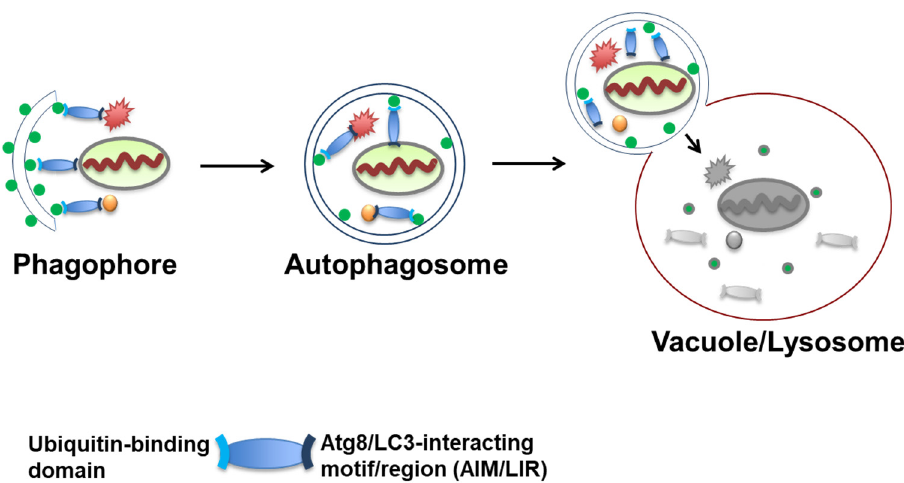
Figure 1. Autophagy pathway begins with the formation of a double-layered isolation membrane (phagophore), which sequesters autophagy cargo such as protein aggregates or organelles. Selective autophagy receptors targets cargos to Atg8/LC3-conjugated isolation membranes. After expansion, the fully formed autophagosome fuses into vacuoles or lysosomes to degrade and recycle their cargoes.